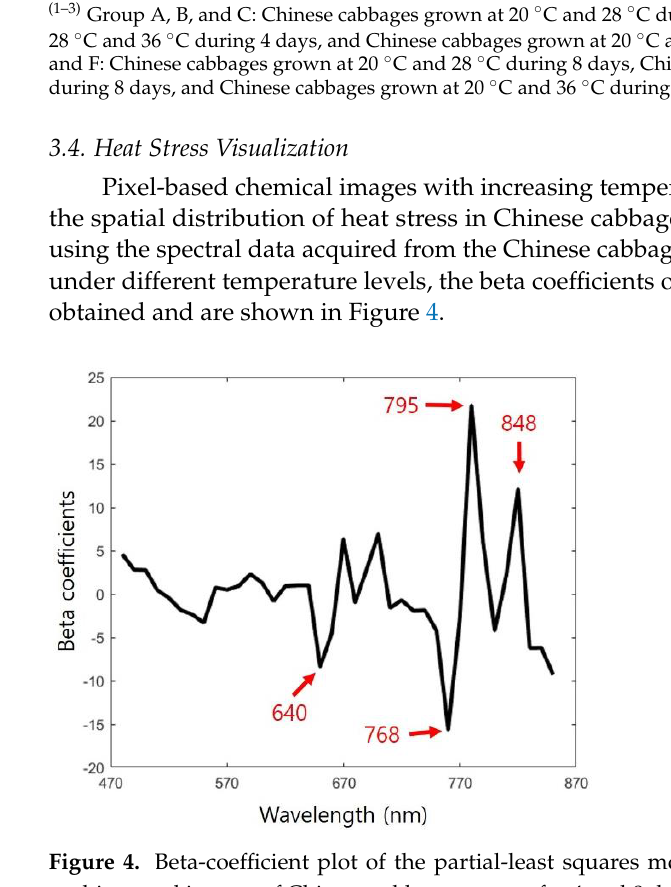
Figure 5. Red, green, and blue (RGB), partial least squares-discriminant analysis (PLS-DA), and least-squares support vector machine (LS-SVM) model images of Chinese cabbage samples grown at 20 °C, 28 °C, and 36 °C for 4 and 8 days. 4. Discussion 4.1. Spectral Analysis Spectral analysis can provide material information related to the chemical composi- tion and physical properties. The Vis/NIR reflectance of plants is mainly characterized by the absorption (or reflection) of leaf pigments, such as chlorophyll, carotenoids, water, proteins, starches, waxes, and structural biochemical molecules [57]. The spectral plot in